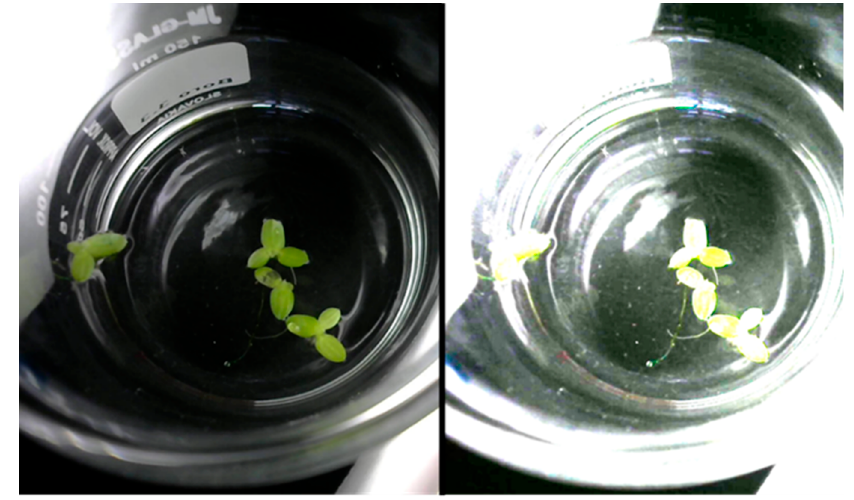
Figure 2. Well exposed ( left ) and overexposed ( right ) Figure 2 Well exposed ( left ) and overexposed ( right ) images.